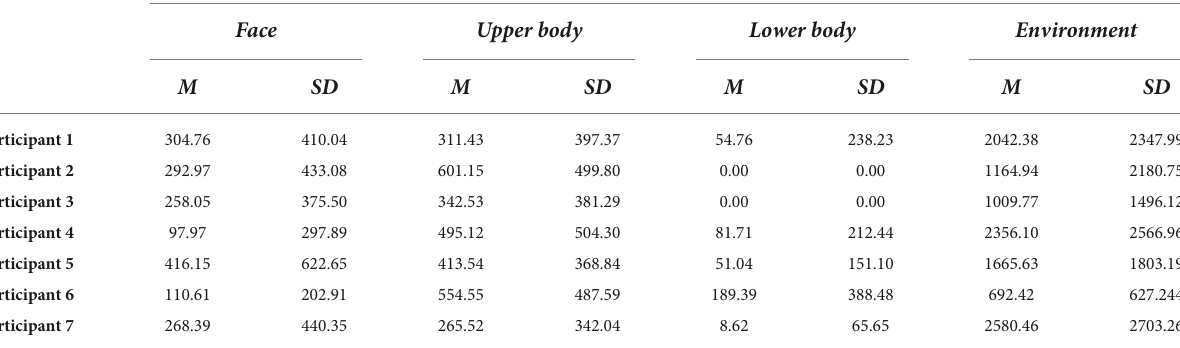
TABLE 2 Means and standard deviation of the fixation durations of the participants on the AOI face, upper body, lower body, and environment included in the statistical